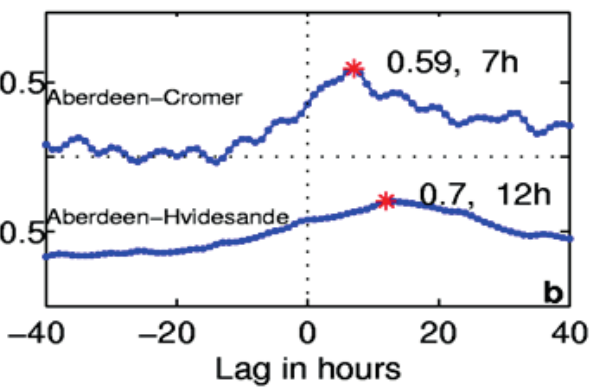
Fig. 3 Cross-correlation between the tide gauge level in Aberdeen and the tide gauge level in Cromer on the central east coast of Britain and the tide gauge in Hvidesande, Denmark (scale 0–1). See Fig. 1 for locations. There is a clear 7 hour time delay between Aberdeen in Scotland in the northwest part of the North Sea and the Cromer tide gauge in the southwest part of the North Sea. The maximum cross- correlation between Aberdeen and Hvidesande is found after 12 hours, corresponding to a 12 hour propagation time of the surge between Aberdeen in the northwest part and Hvidesande in the southeast part of the North